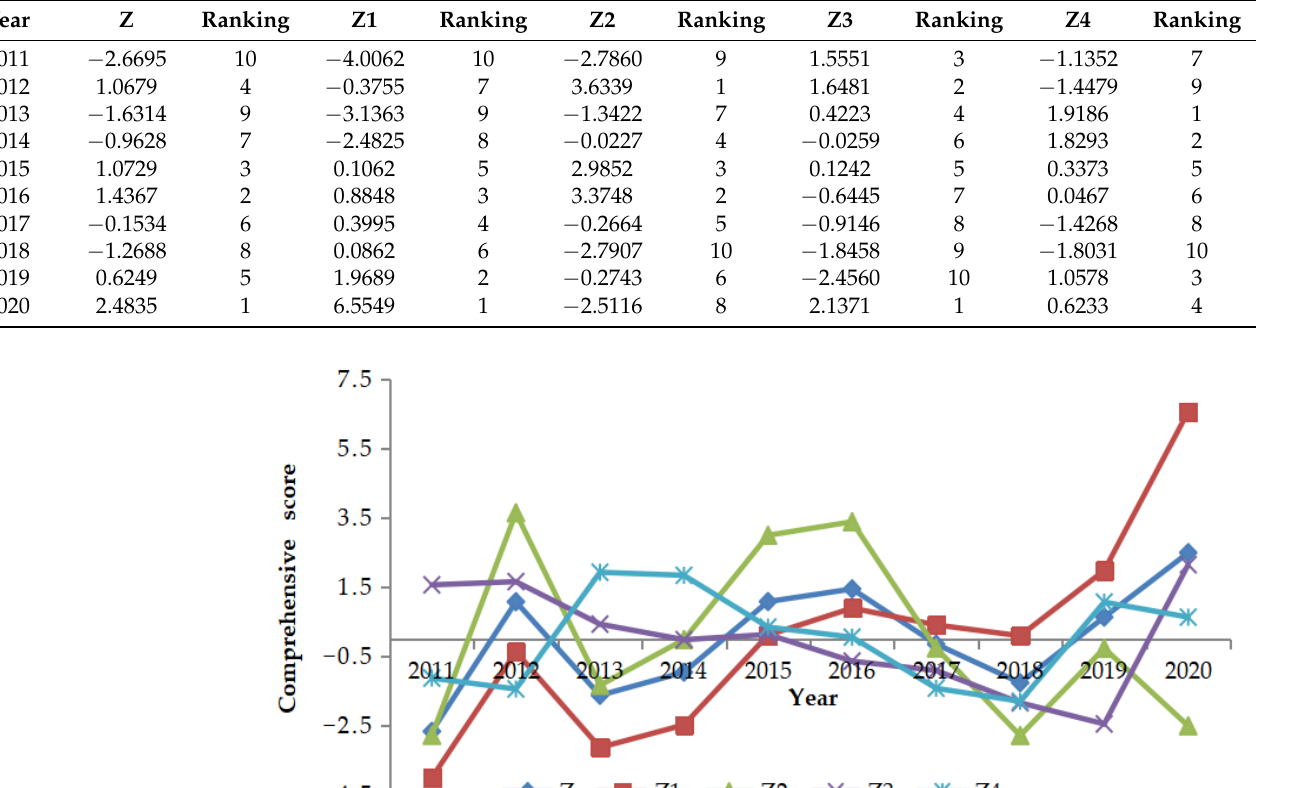
Table 5. Comprehensive score of water ecological civilization in Jiangxi Province.